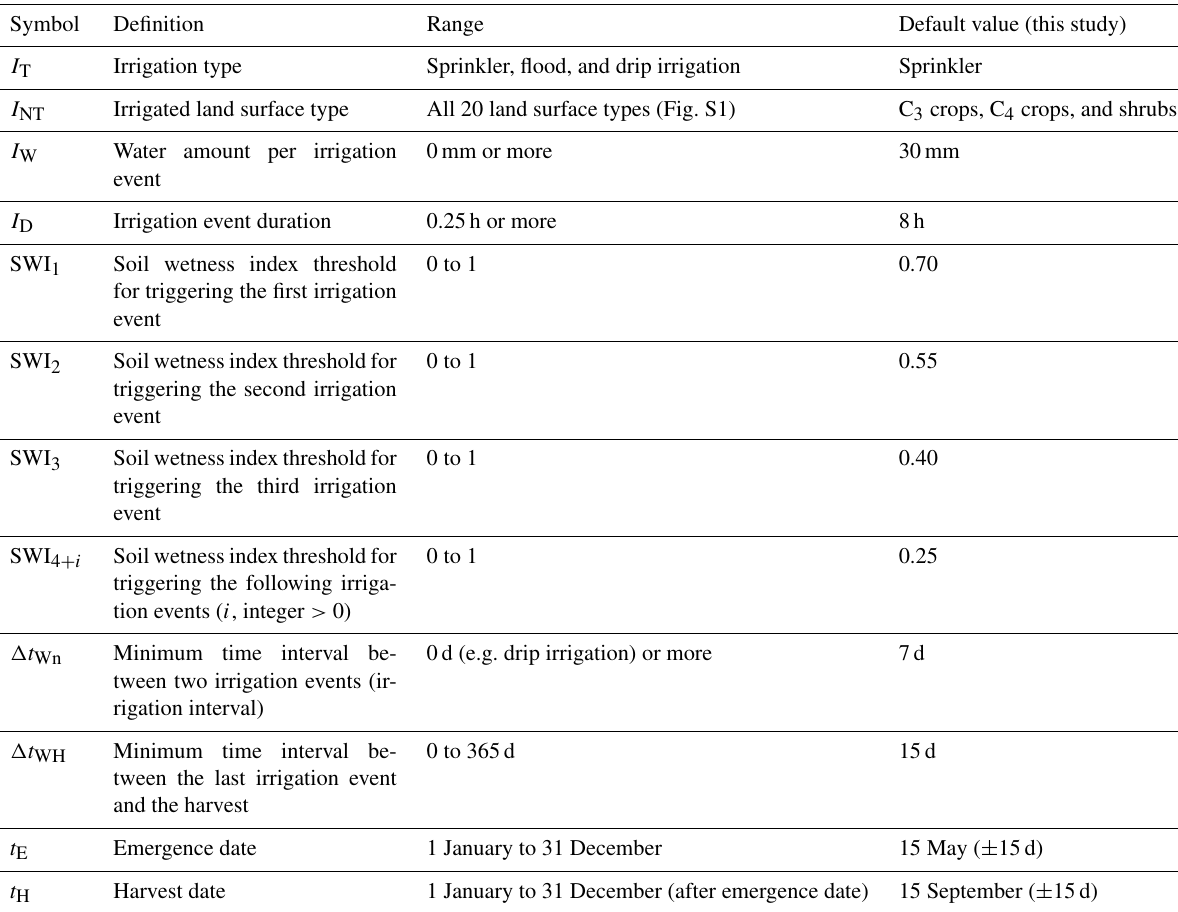
Table 1. Irrigation